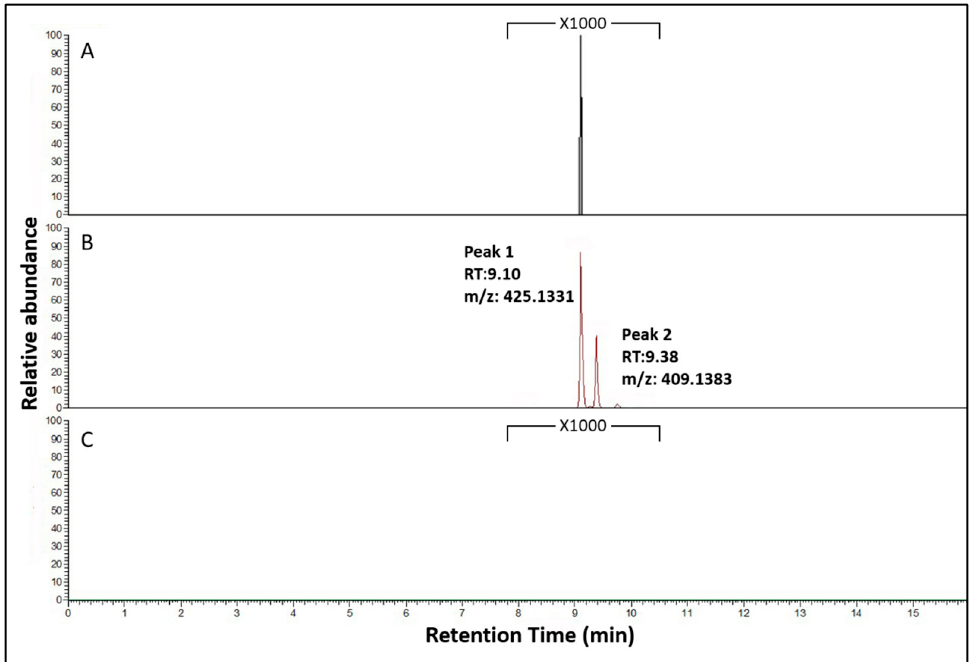
Figure 5. LC-MS analysis of extracts from 6-days-old MM 1% maltose cultures of A. niger strains. Extracted ion chromatogram (EIC) of peak 1/compound 1 and peak 2/compound 2. ( A ) EIC of the parent strain expanded 1000 fold; ( B ) EIC of the mutant NRRL3_00042 OE strain, ( C ) EIC of the mutant NRRL3_00042 OE _ ∆ NRRL3_00036 strain expanded 1000